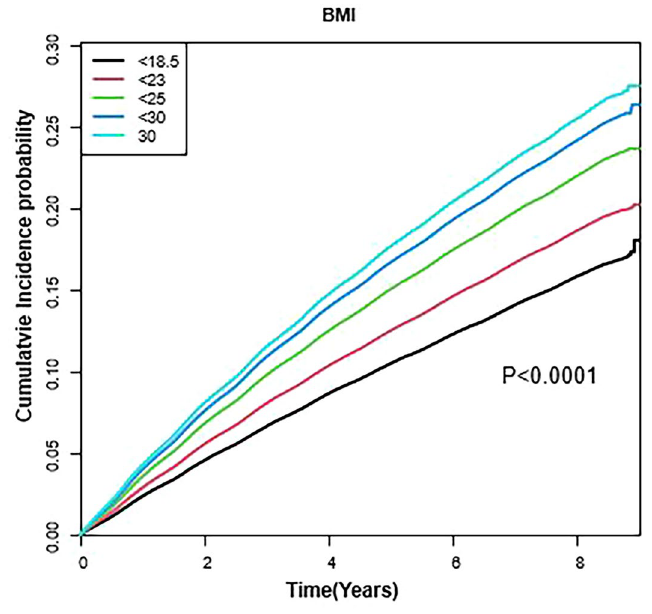
Figure 2. Cumulative incidence of dermatophytosis according to body mass index during the study period. P -values were determined using the log-rank test adjusted for age, sex, smoking status, alcohol consumption, physical activity, household income, diabetes mellitus, hypertension, and